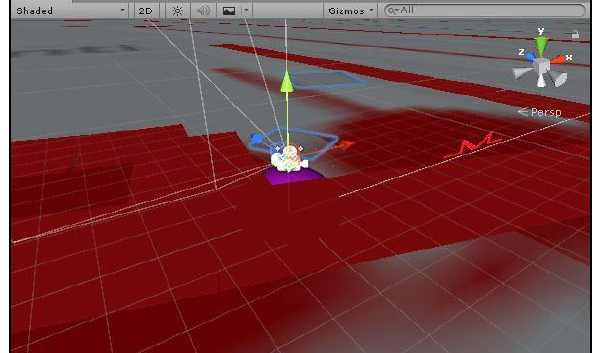
Figure 5. Game objects and AR camera in Unity3D